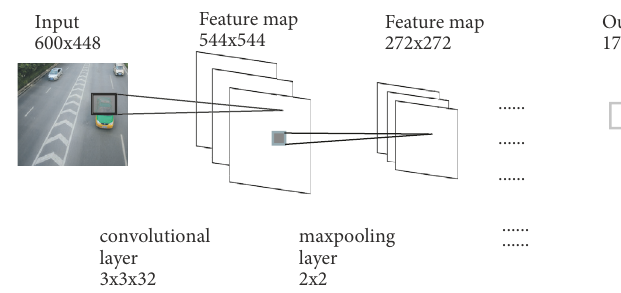
Figure 1: CNN network structure in YOLO v2.